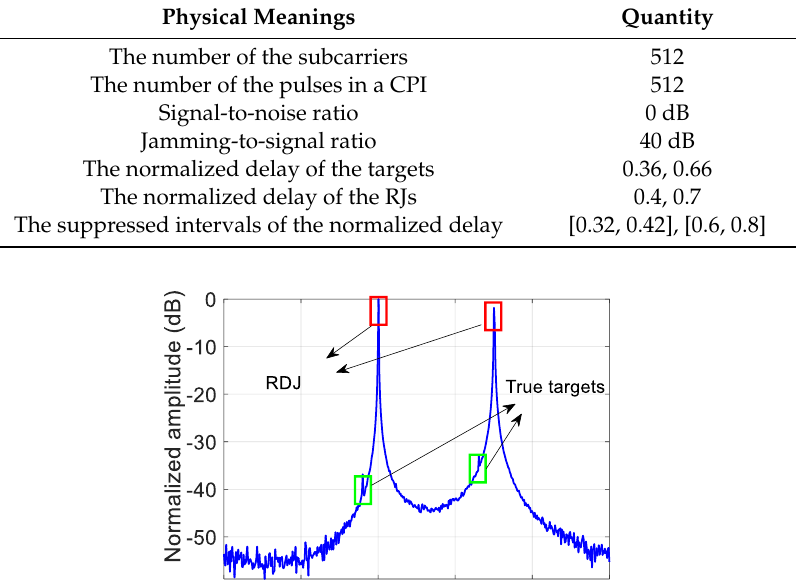
Figure 7. The countermeasure effect in the presence of the RDJ.